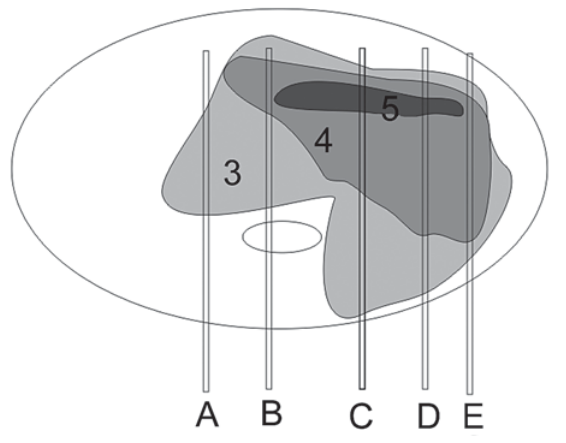
Figure 1 – Differences between the traditional Gleason score (G) and the modified Gleason score in five hypothetical prostatic needle biopsies with prostate cancer.